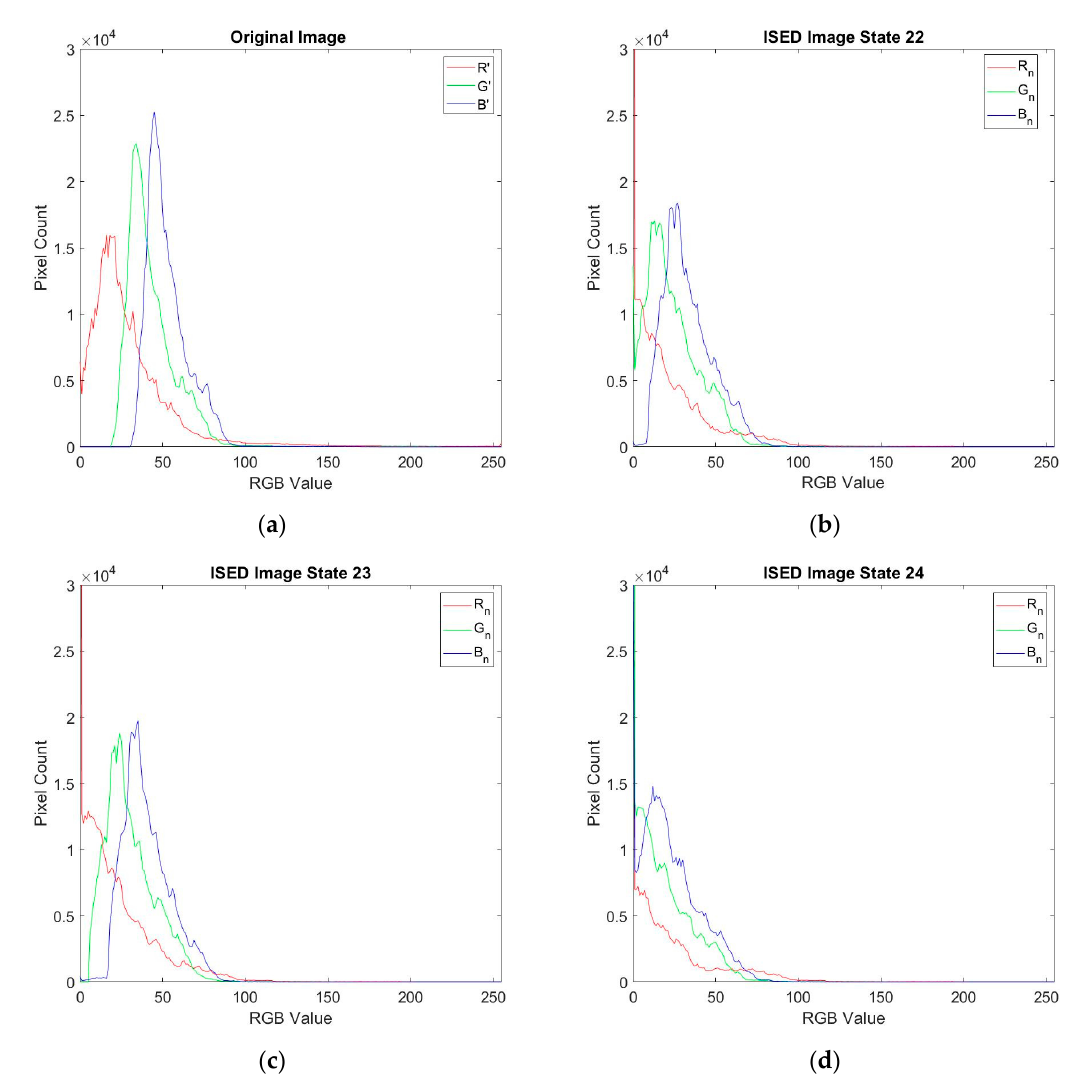
Figure 7 . Histograms of images shown in Figure 5 as the ( a ) original image of M87 in Figure 5a, ( b ) 22 nd ISED-generated image in Figure 5b, ( c ) 23 rd ISED-generated image in Figure 5c, and ( d ) 24 th ISED-generated image in Figure 5d.